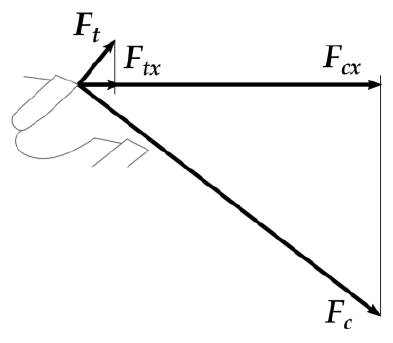
Figure 2. Forces in sawing: F c —cutting force, F t —cutting thrust force, and their horizontal projections: F cx , F tx .